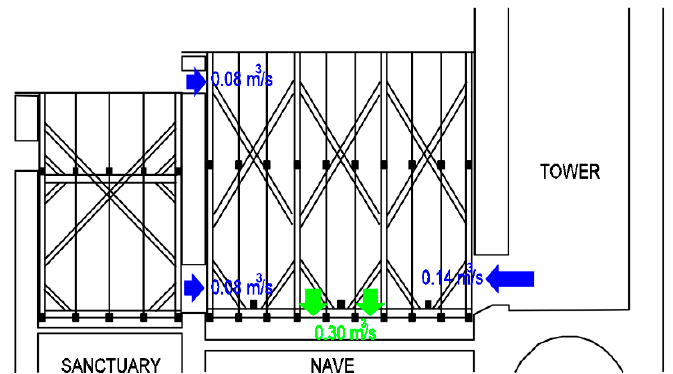
Figure 12. Airflow paths at 6:00 p.m. obtained from BPS simulation in section (blue — inlet, green — outlet).